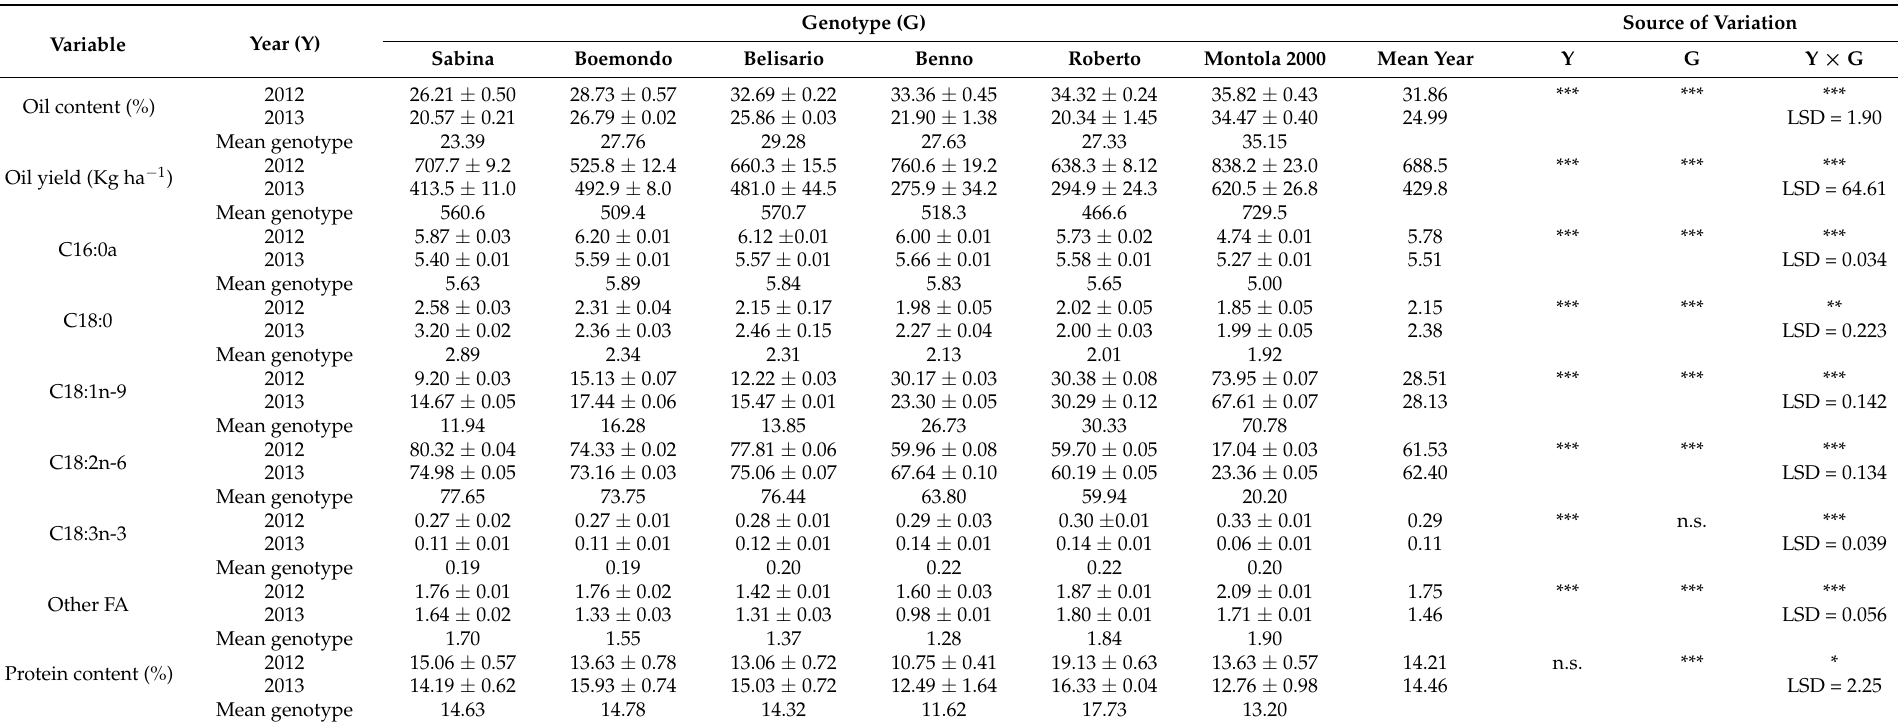
Table 7. Differences in oil content (%), oil yield (kg ha − 1 ), fatty acid composition (% of total FA), and seed crude protein content (%) among six safflower